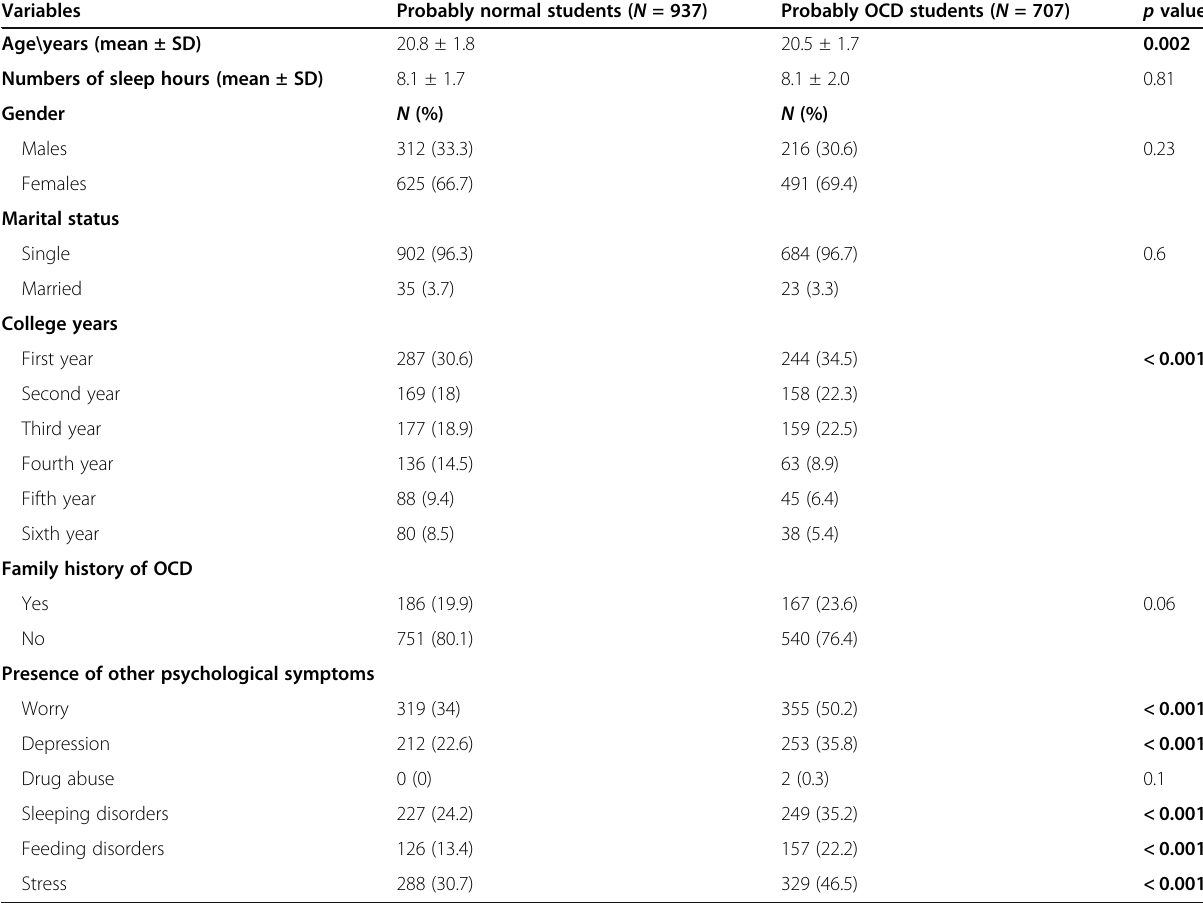
Table 4 Frequency distribution and association of probably normal and OCD among different socio-demographic features Variables